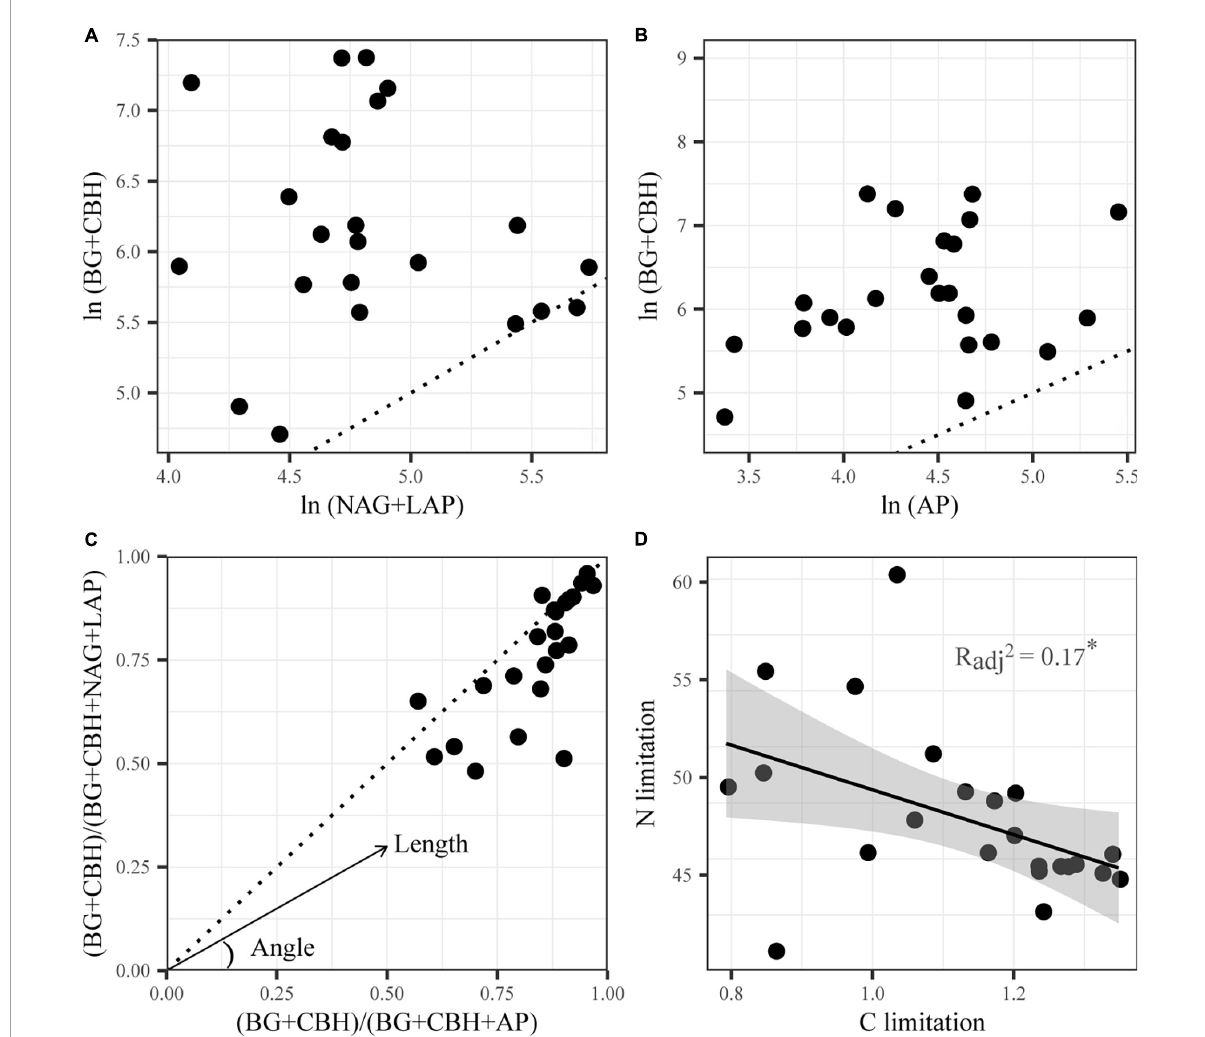
FIGURE1 Stoichiometry of the relative proportion of C- versus N-acquiring enzymes (A) , C- versus P-acquiring enzymes (B) and enzymatic C:N versus C:P (C) , and linear correlations between microbial C and N limitation (D) of Qinghai Lake sediments. BG, β -1,4-glucosidase; CBH, β - D -cellobiosidase; NAG, β -1,4-N-acetylglucosaminidase; LAP, L -leucine aminopeptidase; AP, alkaline phosphatase. A 1:1 dotted line is superimposed (A–C) , which indicates equal acquisition effort by the compared element-acquiring EEA on the x and y axis (Sinsabaugh et al., 2009). Deviations from the 1:1 line imply limitation in favor of the enzyme group where more acquisition effort is